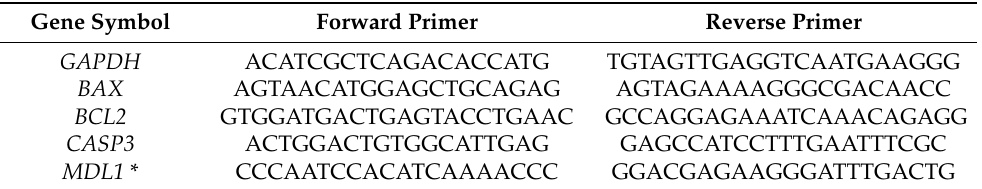
Table 1. Primers for quantitative PCR (qPCR)